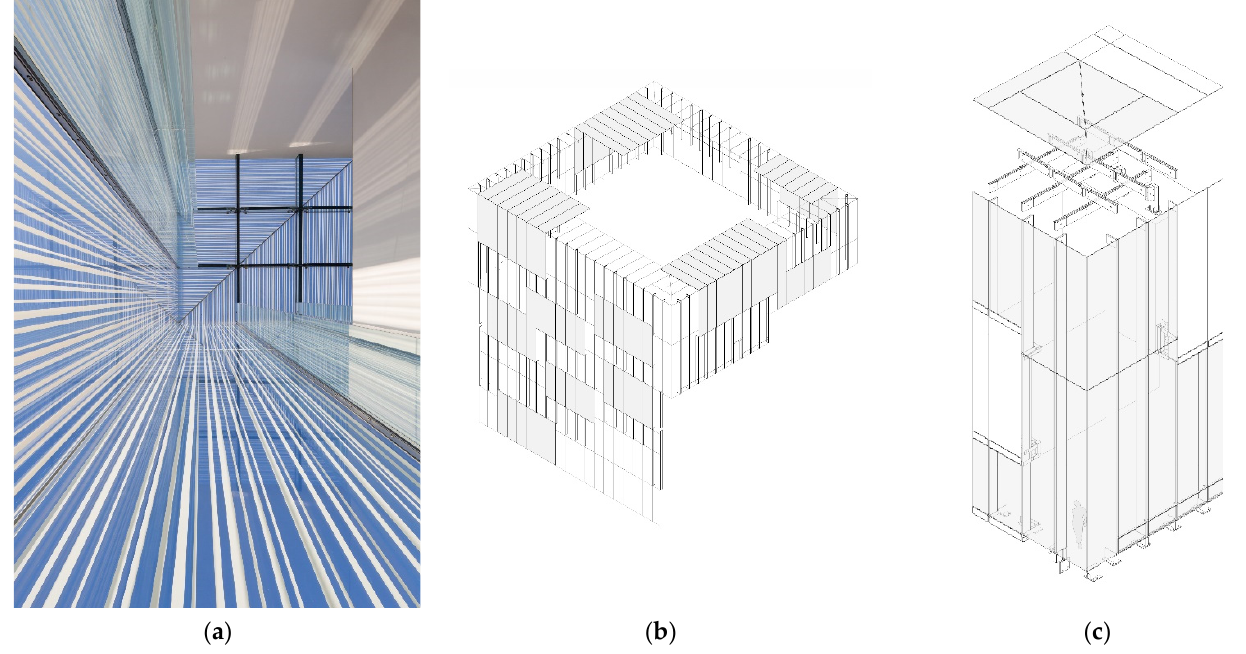
Figure 24. The House of European History in Brussels: ( a ) view of the grillage in the corner of the upper extension (© Christian Richters); ( b ) elements of the glass enclosure (© Chaix & Morel et Associés/JSWD); ( c ) arrangement of glass structural elements in the corner (© Chaix & Morel et Associés/JSWD).